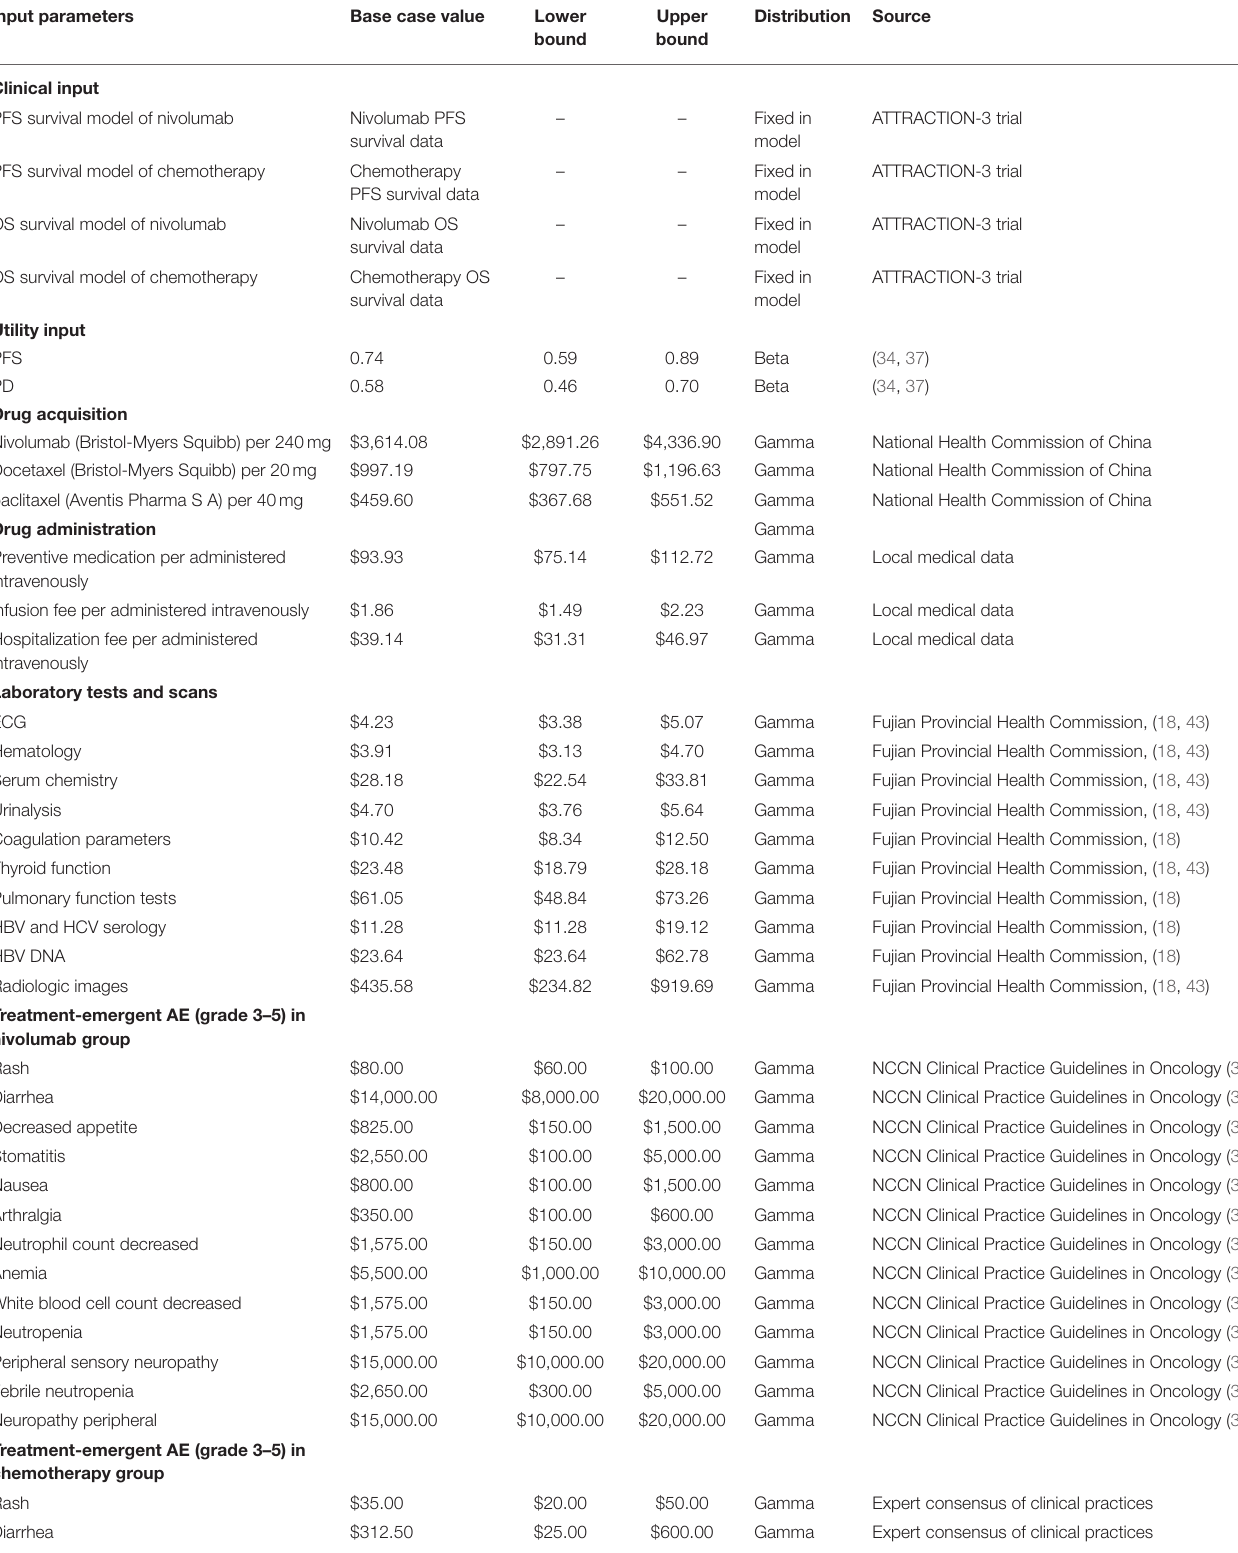
TABLE 1 | Key input parameters to our model and ranges of the sensitivity